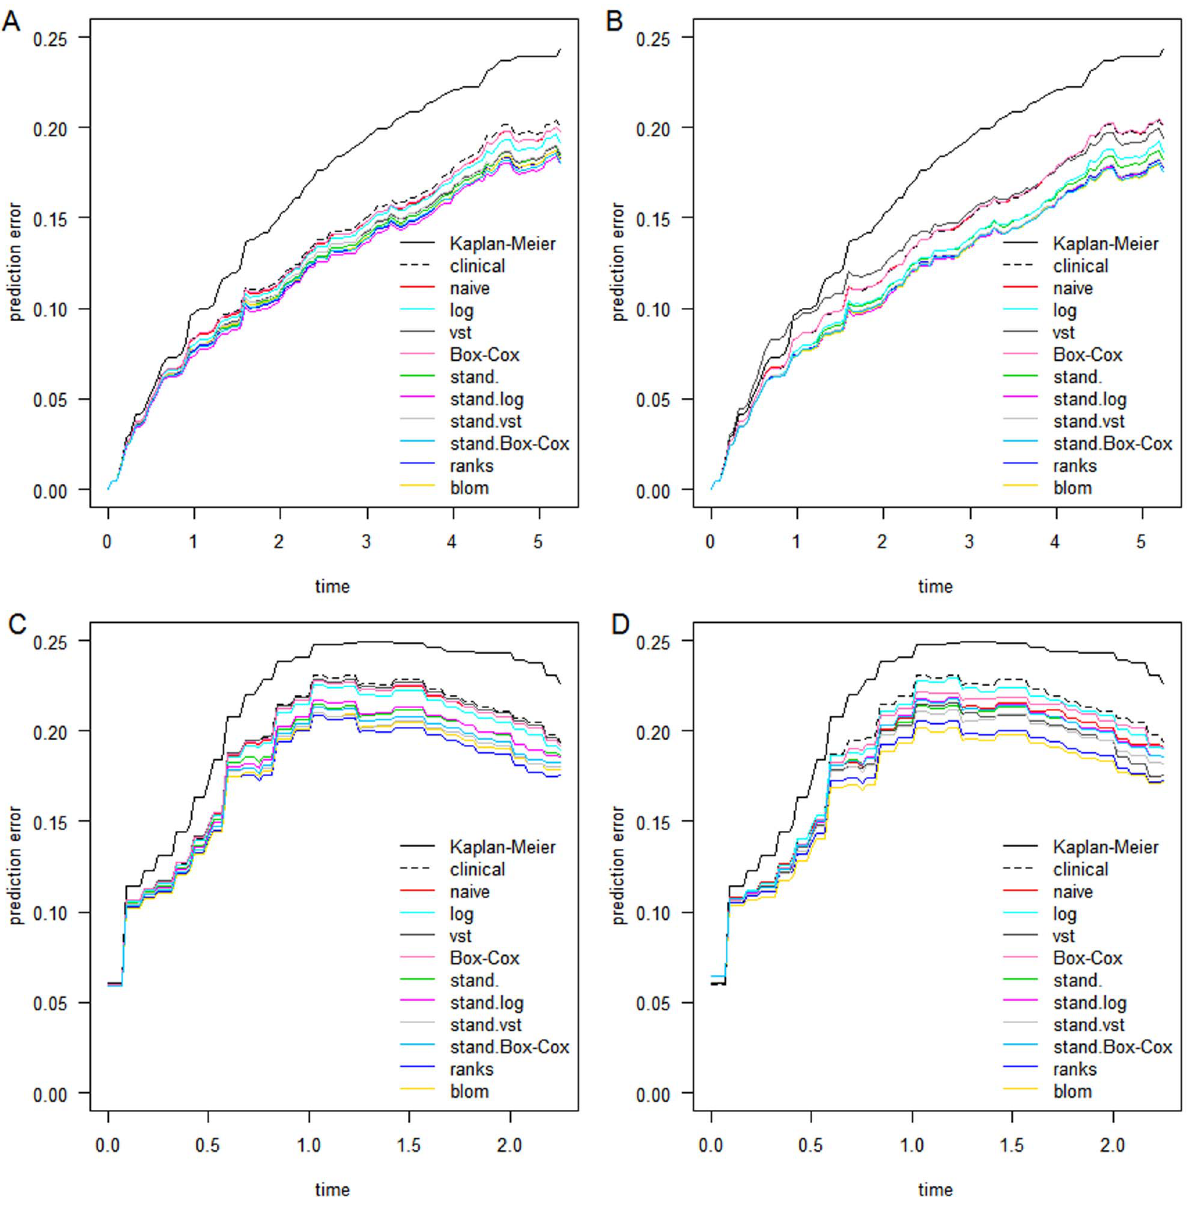
Figure 5. Prediction error for the KIRC and AML data. The 0.632 + estimator for the prediction error in terms of the Brier Score. The solid black line is the prediction error of the Kaplan-Meier estimate which does not include clinical information nor RNA-Seq data, the dashed black line the prediction error of the clinical model. A: CoxBoost model used for prediction on KIRC data. B: Lasso used for prediction on KIRC data. C: CoxBoost model used for prediction on AML data. D: Lasso model used for prediction on AML data.